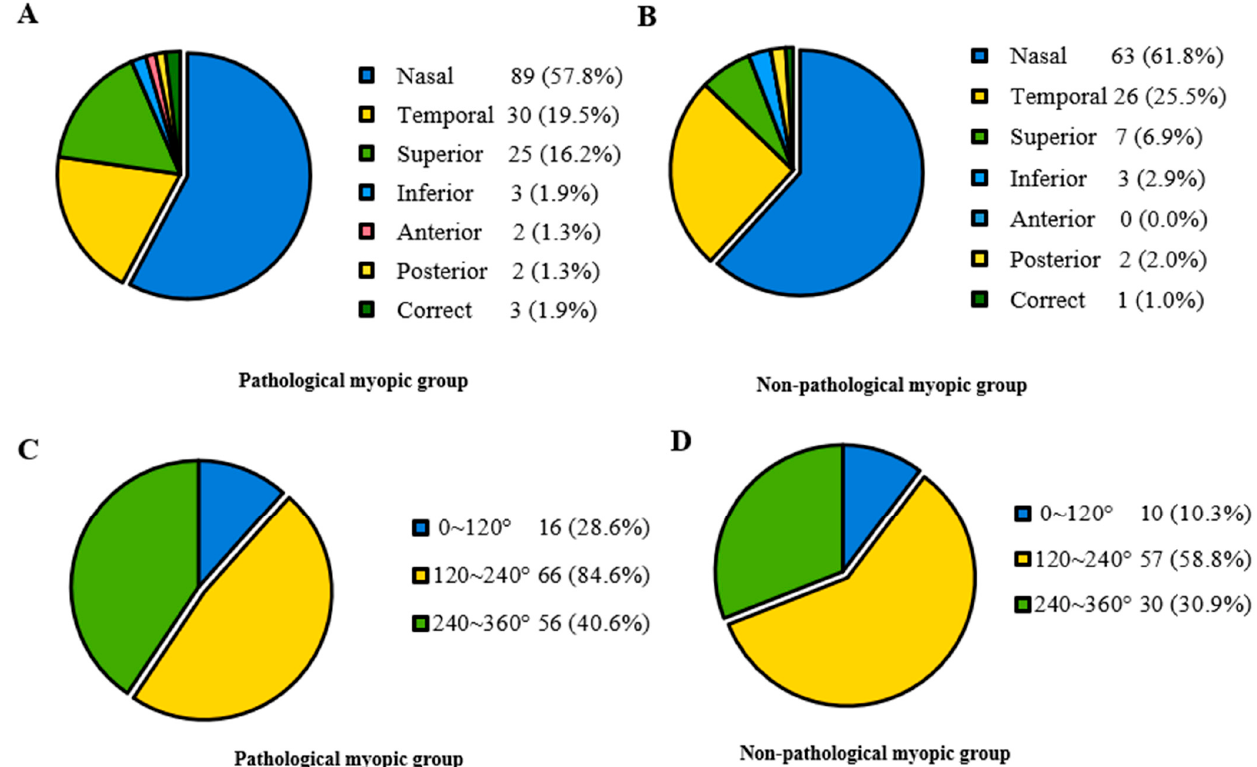
Figure 2. The proportion of lens dislocation direction and range in the Pathological myopic and Non-pathological myopic groups. ( A ) Lens dislocation direction in the Pathological myopic group, revealing most participants displayed nasal, temporal and superior lens displacements. ( B ) Lens dislocation direction in the Non-pathological group, revealing most participants displayed nasal, temporal and superior lens displacements. ( C ) Lens dislocation range in the Pathological myopic group, revealing most participants displayed moderate to severe range. ( D ) Lens dislocation range in the Non-pathological myopic group, revealing most participants displayed moderate to severe range. Table 4. Characteristics and Comparison among Pathological Myopic Eyes with Three Different Maculopathy Types.